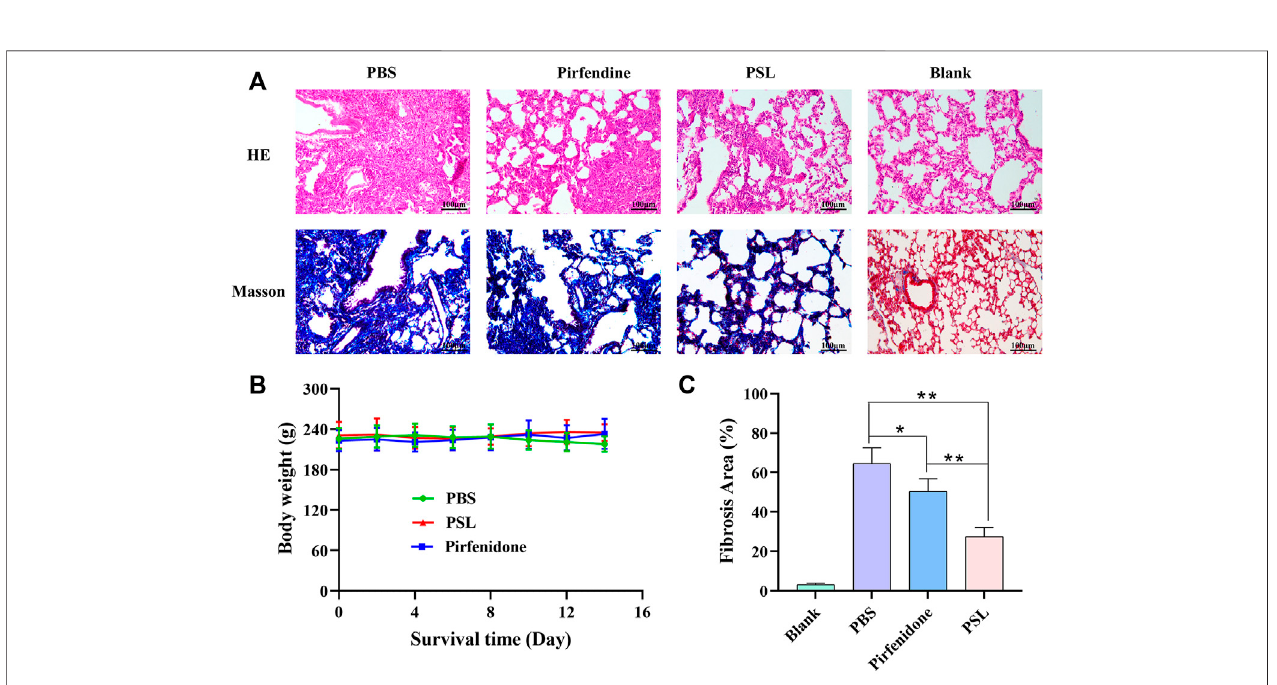
FIGURE 9 | Results of H&E staining and Masson staining in rats with and without pulmonary fi brosis (A) . Body weight changes in mice from each group (B) . Quanti fi cation of fi brosis area in rats ( n = 4) (** p < 0.01, * p < 0.05) (C) .